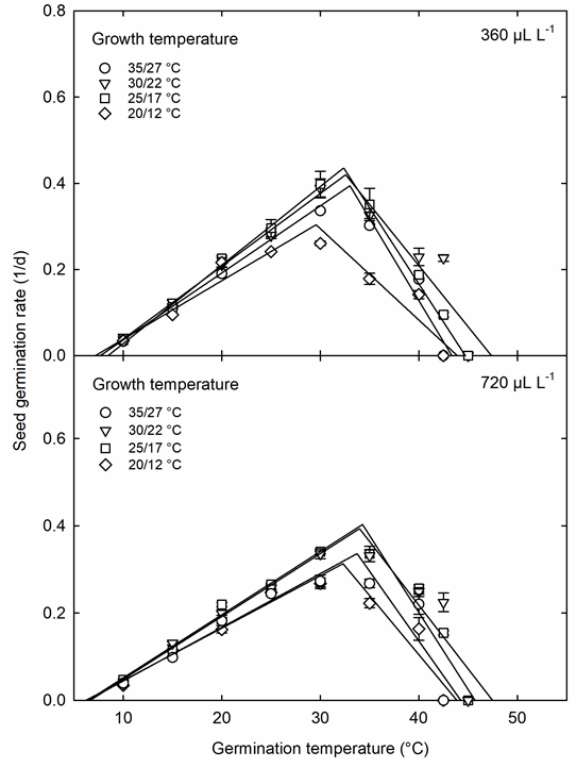
Figure 4. Effect of germination temperatures on the seed germination rate of eight parental environments described by modified bilinear functions. Data are means ± SE of four plants ( n = 4) harvested from a given SPAR unit and used as replicates in statistical analysis for a respective parental environment.